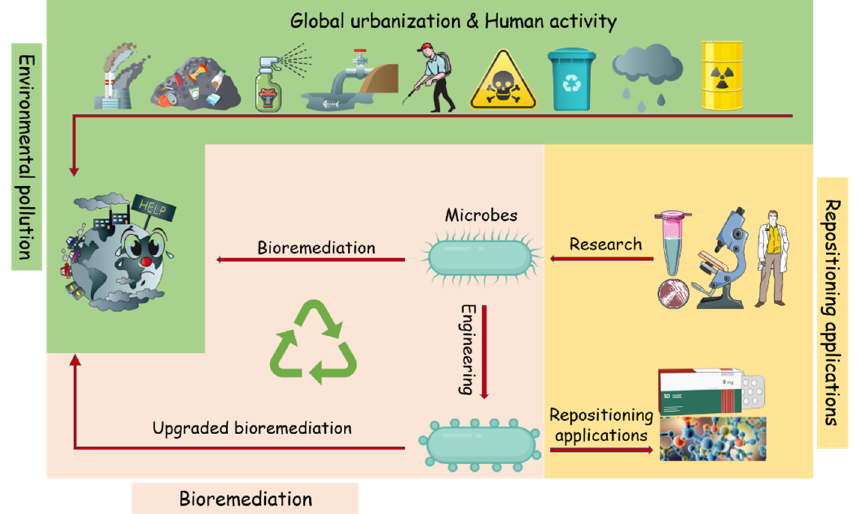
Figure 1. Schematic illustration of the microbial bioremediation of environmental pollutants and its “expanded” applications. Emerging contaminants are often released into the environment, causing harmful impacts and health problems. Researches on the mechanism of the pollutants bioremediation microbes and enzymes will help the application of bioremediation to environmental clean-ups, and the characterize enzymes will also contribute to industrial processes such as pharmaceutical and chemical compounds.